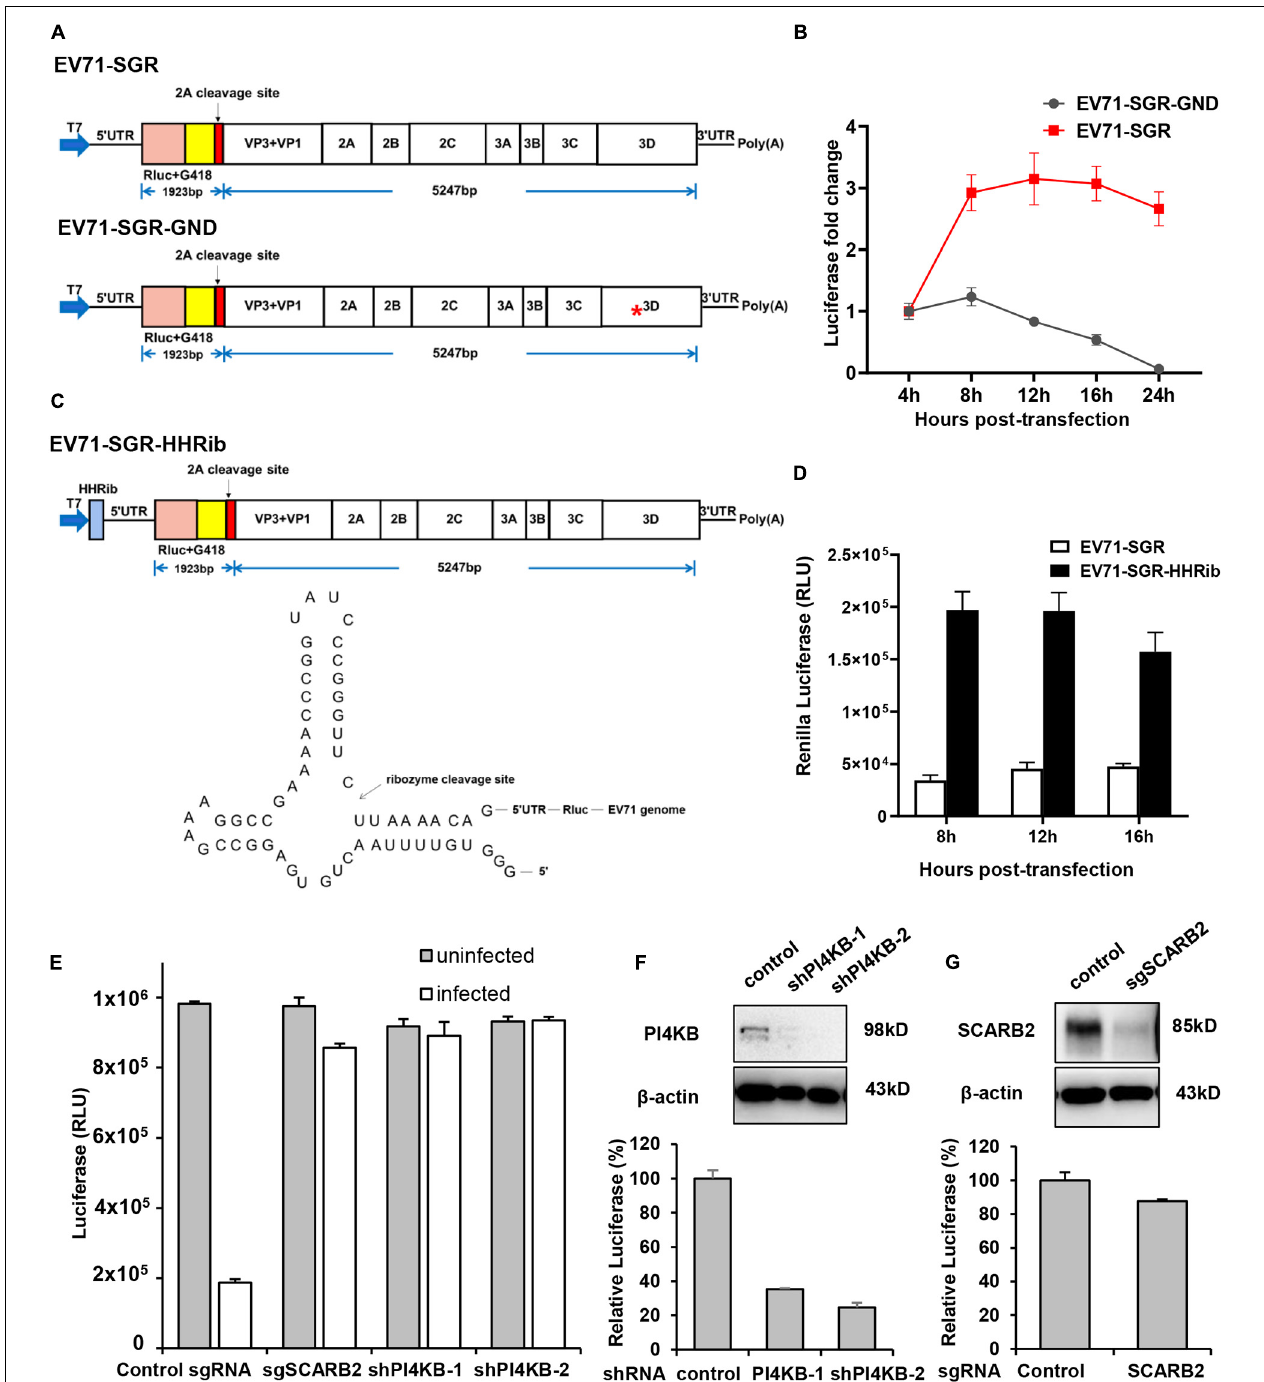
FIGURE 4 | Characterization of EV71 subgenomic replicon. (A) Diagram showing the structure of the EV71 subgenomic replicons. Asterisk indicates the GND mutation in the polymerase catalytic site. (B) RD cells transfected with EV71 SGR or SGR GND mutant were assayed for luminescence at various time points. (C) Diagram showing the structure of the EV71-HHRib subgenomic replicons. The lower panel showed the RNA structure and the cleavage site of HHRib. (D) RD cells transfected with EV71 SGR or EV71-SGR-HHRib were assayed for luminescence at various time points. (E) RD cells transduced with control sgRNA or SCARB2 sgRNA, PI4KB shRNA lentivirus were either mock infected or infected with EV71 virus for 24 h and cell viability was determined with Cell Titer Glo. (F) RD cells transduced with control or PI4KB shRNA lentivirus were transfected with EV71 SGR RNA and luciferase activity was determined 12 h post-transfection. Cells described above were also immunoblotted with the indicated antibody to show the inhibition of PI4KB. (G) RD cells transduced with control or SCARB2 sgRNA lentivirus were transfected with EV71 SGR RNA and luciferase activity was determined 12 h post-transfection. Cells described above were immunoblotted with the indicated antibody to show the inhibition of